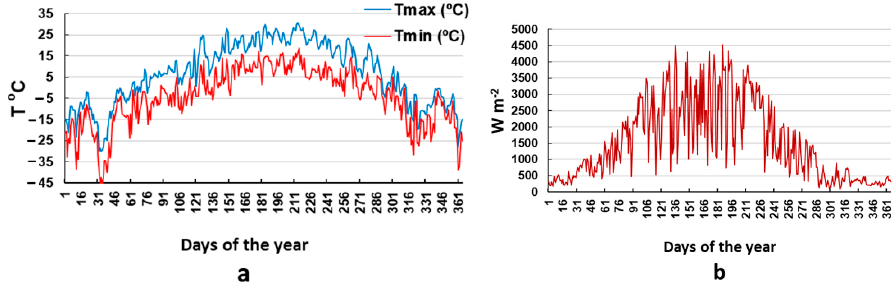
Figure 2. Annual dynamics of daily air temperature in 2019 according to the Bakchar weather station ( a ) and solar radiation ( b ) in the studied area in 2019.